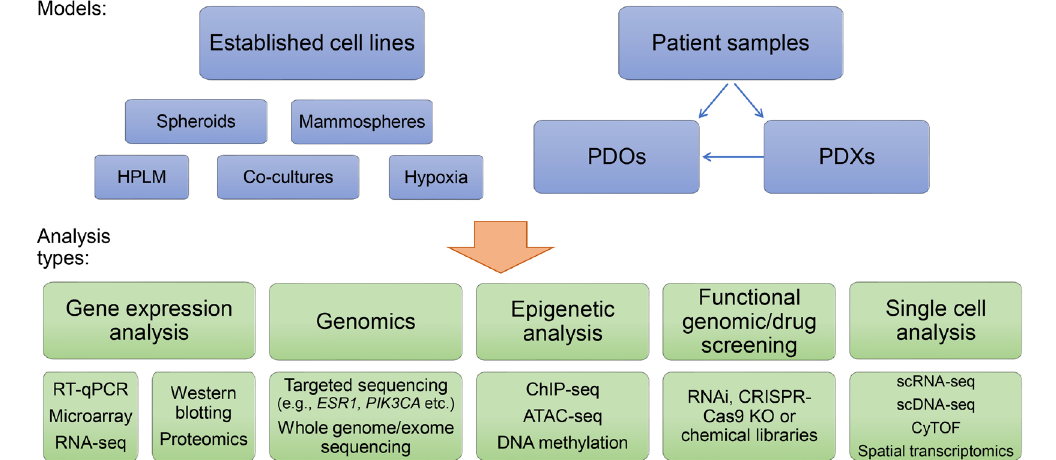
Figure 4. In vitro breast cancer endocrine resistance models and opportunities for their analysis. RT-qPCR: quantitative reverse transcription polymerase chain reaction; HPLM: human plasma-like medium